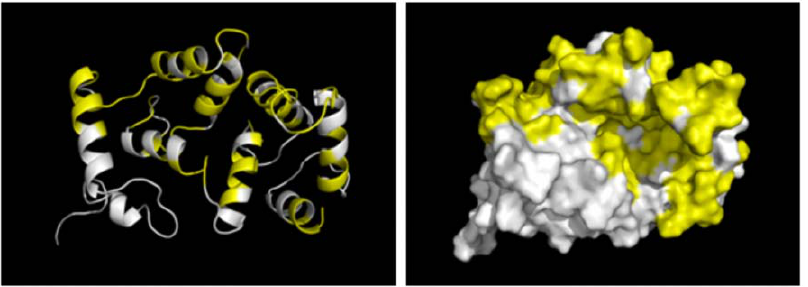
Figure 5. NMR-derived D2 binding site on NCS-1. (Left) Cartoon diagram of NCS-1 with residues that show significant changes in chemical shifts and/or line-widths coloured in yellow. (Right) Molecular surface of NCS-1 in the same orientation as the left-hand figure showing that many of the residues affected by the presence of D2SR are in or surround the hydrophobic crevice of NCS-1. The structures were created using the program Pymol (The PyMOL Molecular Graphics System, Version 1.3, Schro¨dinger, LLC).